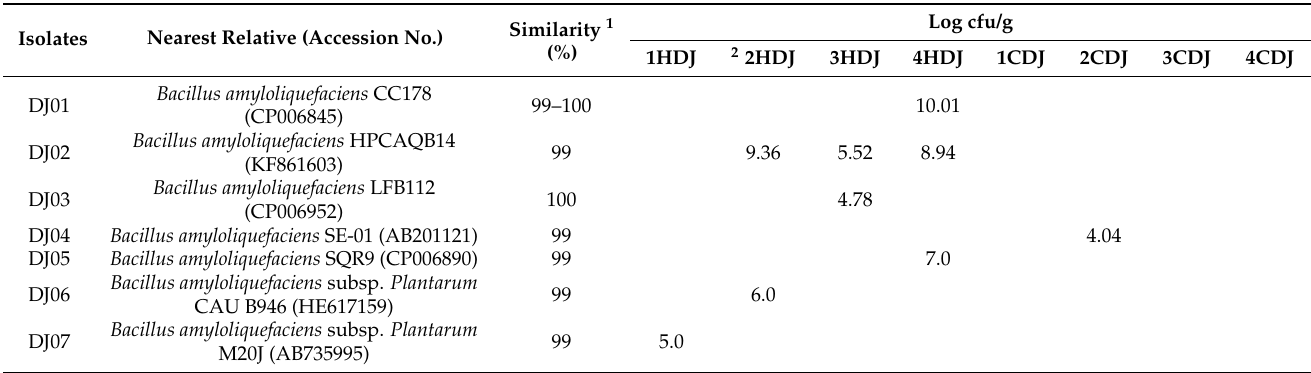
Table 2. Comparisons of 16S rRNA sequence similarity and viable cell numbers of isolates from household and commercial doenjang